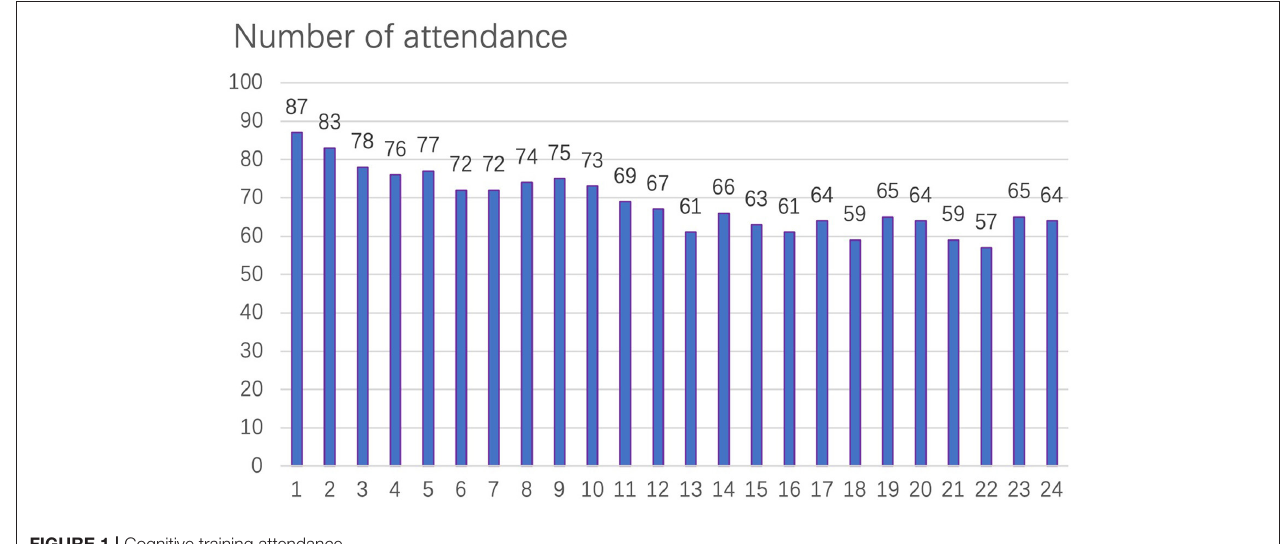
FIGURE 1 | Cognitive training attendance.